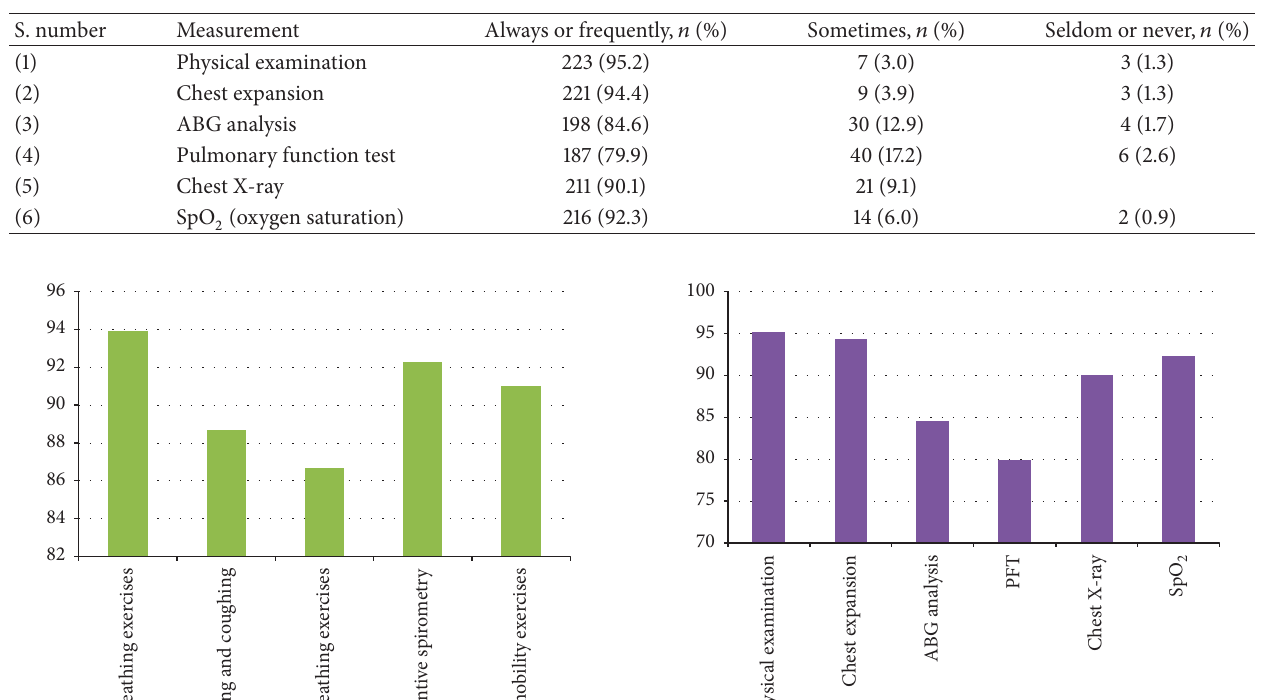
Table 4: Postoperative assessment for thoracic surgery patients.